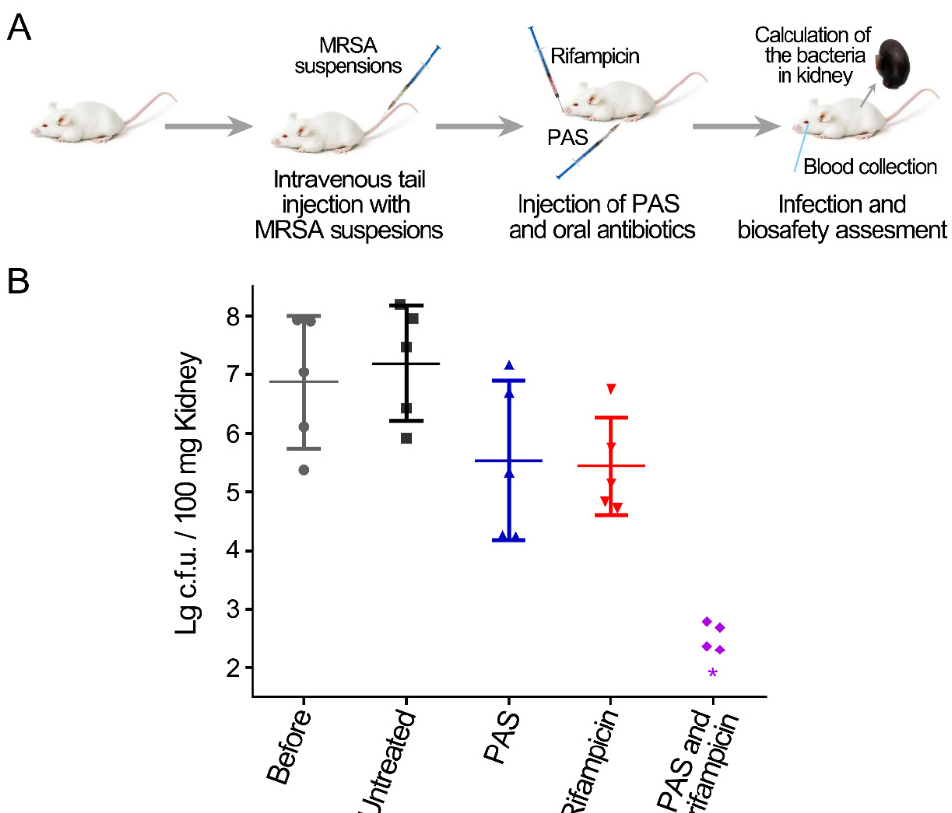
Figure 3. Treatment of MRSA systemic infection by the combination of PAS and rifampicin in the murine model. ( A ) Schematic representation of the wound model and PAS and antibiotic treatment. ( B ) MRSA systemic infection improved by the combined treatment of PAS and rifampicin. Groups of five Balb/c mice were used. Colony-forming units (c.f.u.) from one kidney of each mouse were plotted as individual points and error bars represent the standard deviation (SD) within an experimental group. Gray circles, the infected group before treatment; black squares, the untreated group; blue regular triangles, the group treated with the PAS; red inverted triangles, the group treated with rifampicin; purple rhombuses, the group treated with the combination of the PAS and rifampicin. The asterisks represent that the number of the colonies was less than the detection limit.